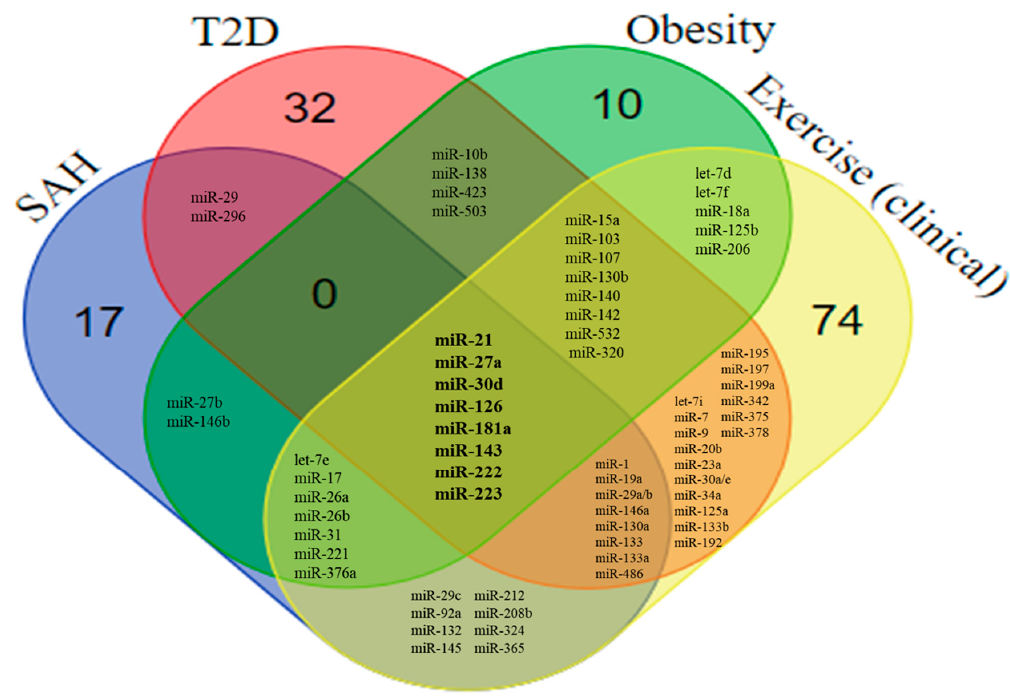
Figure 5. A Venn diagram of hypertension, diabetes, obesity, and their overlapping with exercises (clinical). The Venn diagram was used to identify overlapping and non-overlapping miRNAs in the analysis of studies on the microRNA profile of expression in cardiometabolic diseases and clinical studies on exercise training.